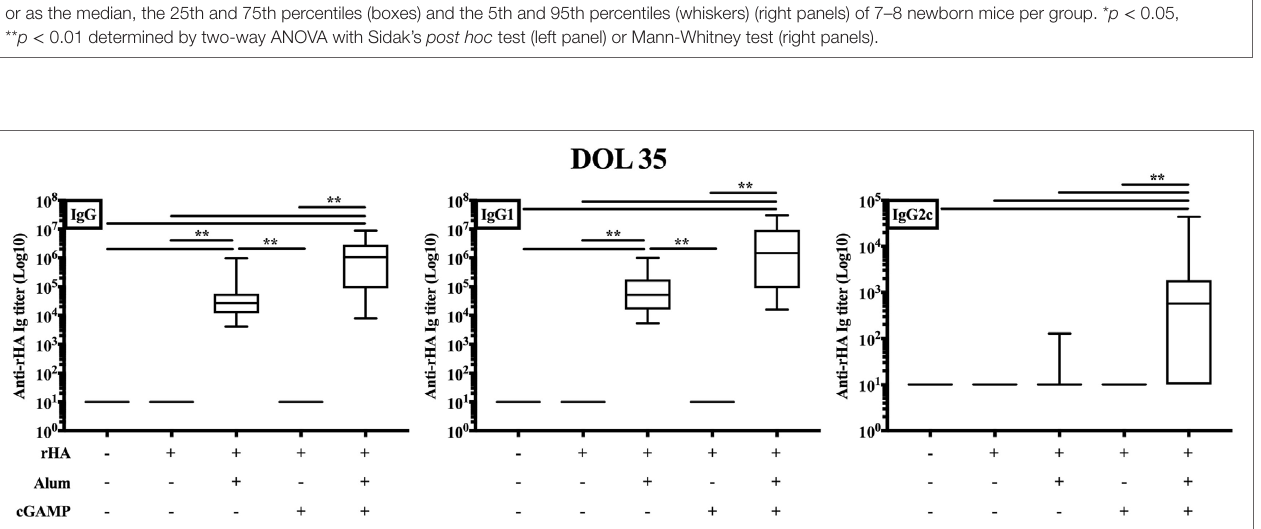
FigUre 7 | Single-dose immunization of newborn mice with (cGAMP + alum) significantly increases anti-recombinant hemagglutinin (rHA) IgG2c titers. Newborn mice were immunized i.m. with saline, rHA alone or formulated with alum, cGAMP or (cGAMP + alum) and antibody titers for rHA-specific IgG, IgG1, and IgG2c were determined by ELISA in serum samples collected 28 days after boost [day of life (DOL) 35]. Results are shown as the median, the 25th and 75th percentiles (boxes), and the 5th and 95th percentiles (whiskers) of 9–13 mice per group. ** p < 0.01 determined by Kruskal–Wallis with Dunn’s post hoc test.